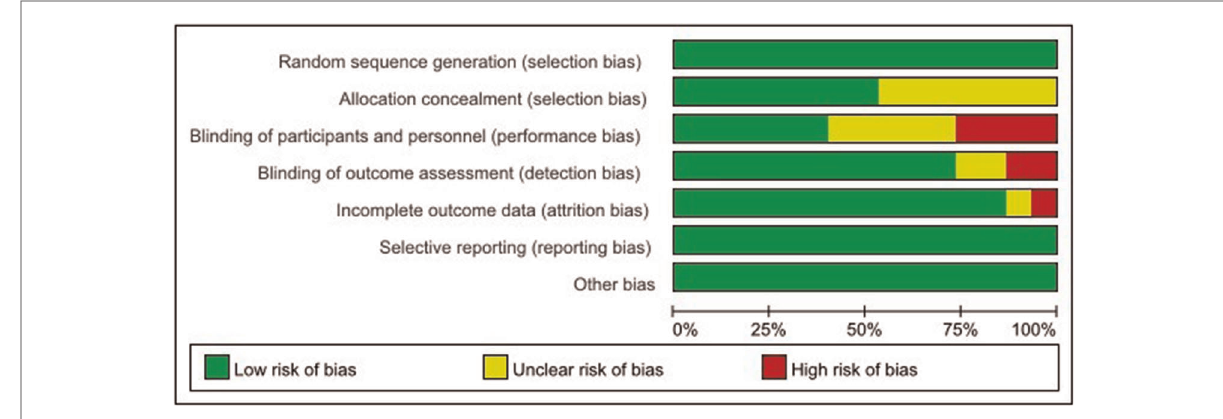
FIGURE 3 The quality assessment of each study.